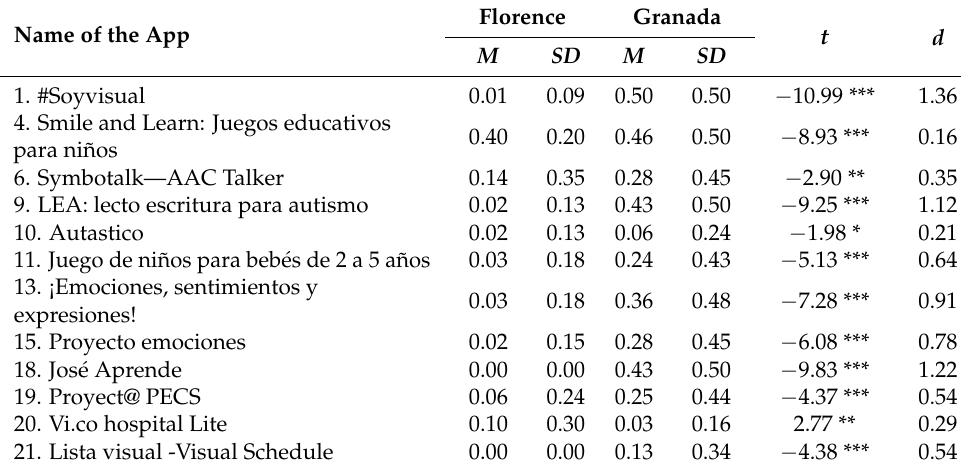
Table 16. Statistically significant differences in the use of specialized apps according to the city of origin. Name of the